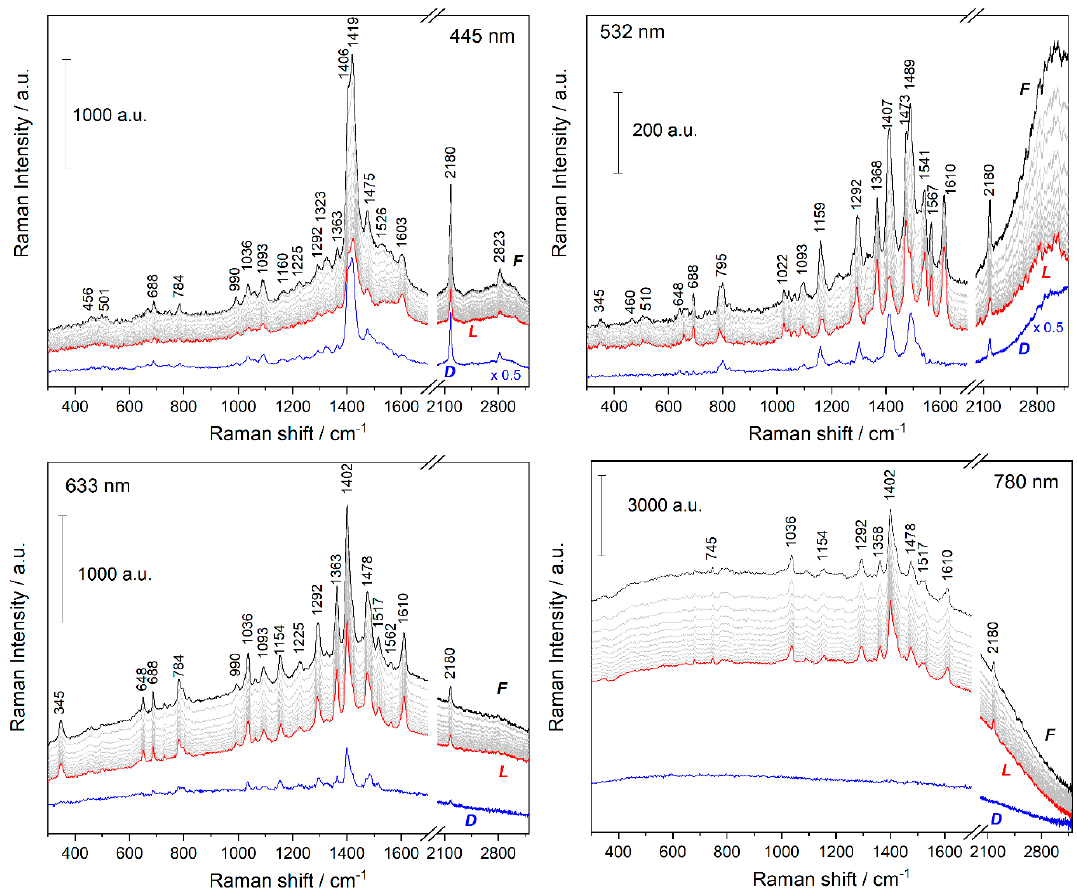
Figure 4. Time evolutions of the Raman spectra of FeET films measured using various λ exc . Black—first RS ( F ); red—last measured RS ( L ); blue ( D = F − L )—difference spectrum. Accumulation time 15 s; total time 6–9 min; laser power at the sample: 0.1 mW for 532 and 633 nm and 5 mW for 445 and 780 nm.